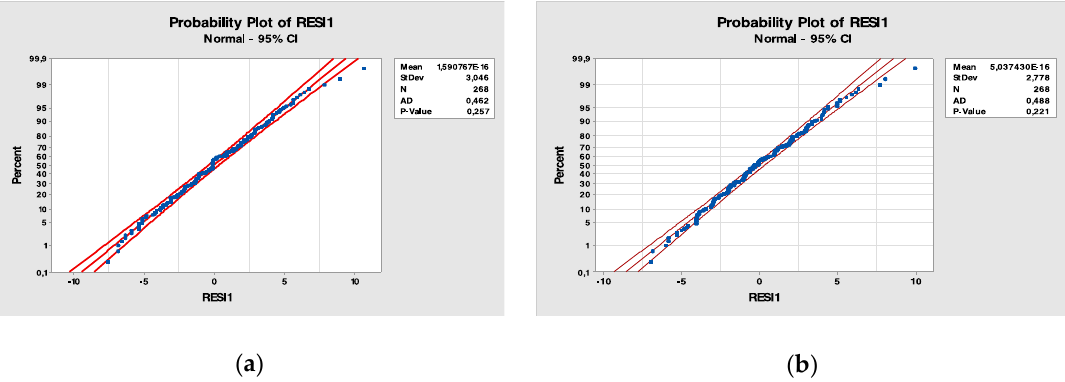
Figure 4. ( a ) Probability plot of the residuals for the variable “bookings” grouped according to the factor “month”; ( b ) Probability plot of the residuals for the variable “bookings” grouped according to the factor “day”. Table 2. One-way ANOVA results. (DF = Degree of Freedom; Adj SS = Adjusted sums of squares; Adj MS = Adjusted mean